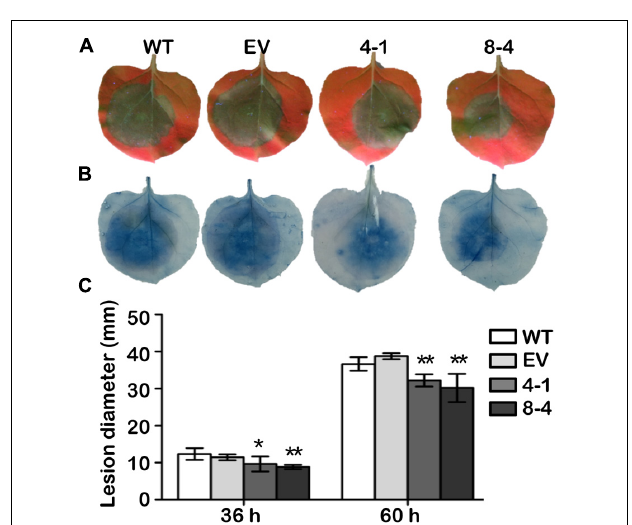
FIGURE 7 | GmDAD1 enhances resistance to P. parasitica in N. benthamiana . (A) Detached leaves from wild type (WT), empty vector control (EV) and GmDAD1 overexpression plants (4-1 and 8-4) were inoculated with P. parasitica zoospores. Photographs were taken at 60 hpi under a UV lamp. (B) Trypan blue staining of the P. parasitica inoculated N. benthamiana leaves. (C) Lesion diameter of inoculated leaves measured at 36 and 60 hpi. The lesion size was calculated from 20 leaves ± SD with three biological repeats. Data were analyzed by using Student’s t -tests ( ∗ P < 0.05, ∗∗ P < 0.01 compared with the